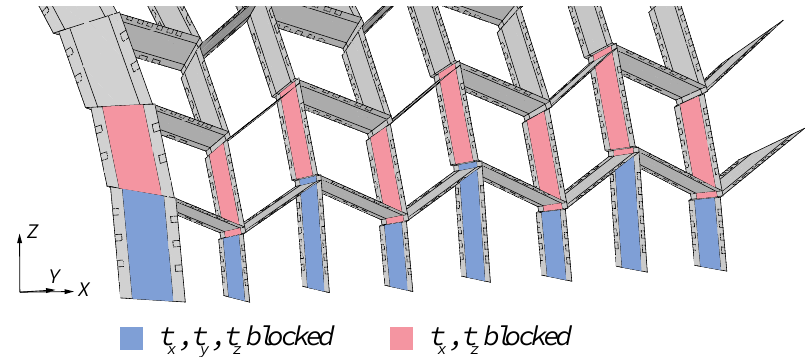
Figure 12. Numerical modelling of the boundary conditions applied on the coarse mesh area of vertical plates. Translations in X , Y and Z were blocked on the first row of boxes (in blue) and translations in Y and Z were blocked on the second row of boxes (in